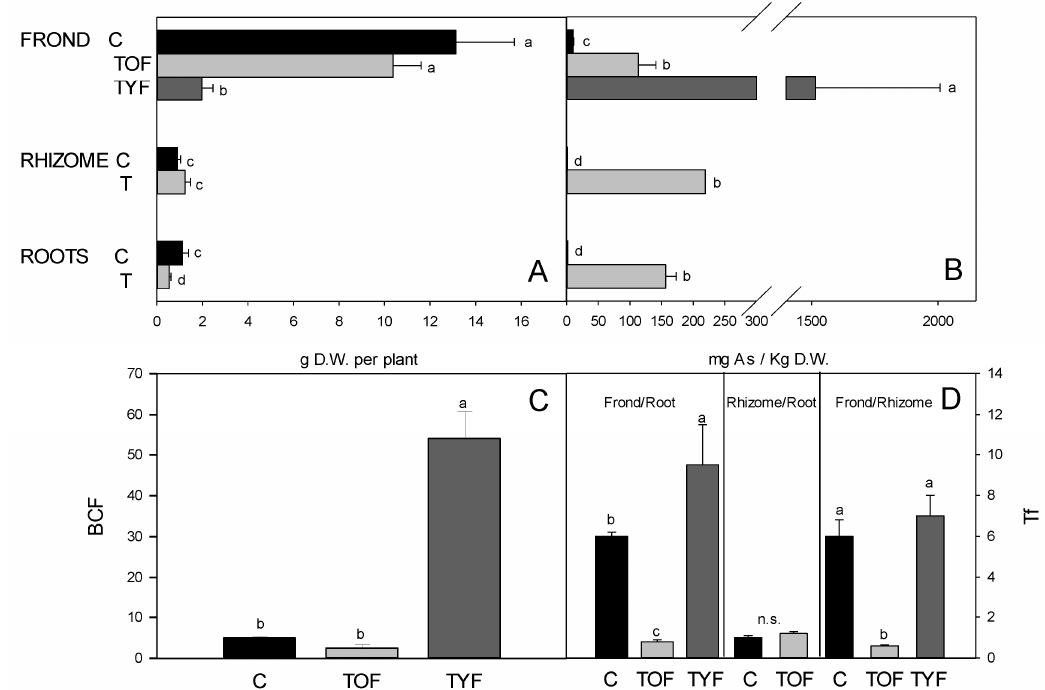
Figure 2. Biomass allocation ( A ), arsenic concentration ( B ), bioconcentration factor (BCF, ( C )), translocation factor (Tf, ( D )) in Pteris vittata L. plants treated (T) or not ( C ) for 9 weeks with 28 mg L − 1 Na 2 HAsO 4 · 7H 2 O under hydroponic conditions in greenhouse (TOF, treated old fronds; TYF, treated young fronds). Horizontal ( A , B ) and vertical bars ( C , D ) represent means ( n = 5) ± S.D. Two-way ANOVA ( A , B ) or one-way ANOVA ( C , D ) were applied; di ff erent letters indicate significant di ff erence according to Tukey’s test ( p ≤ 0.05).